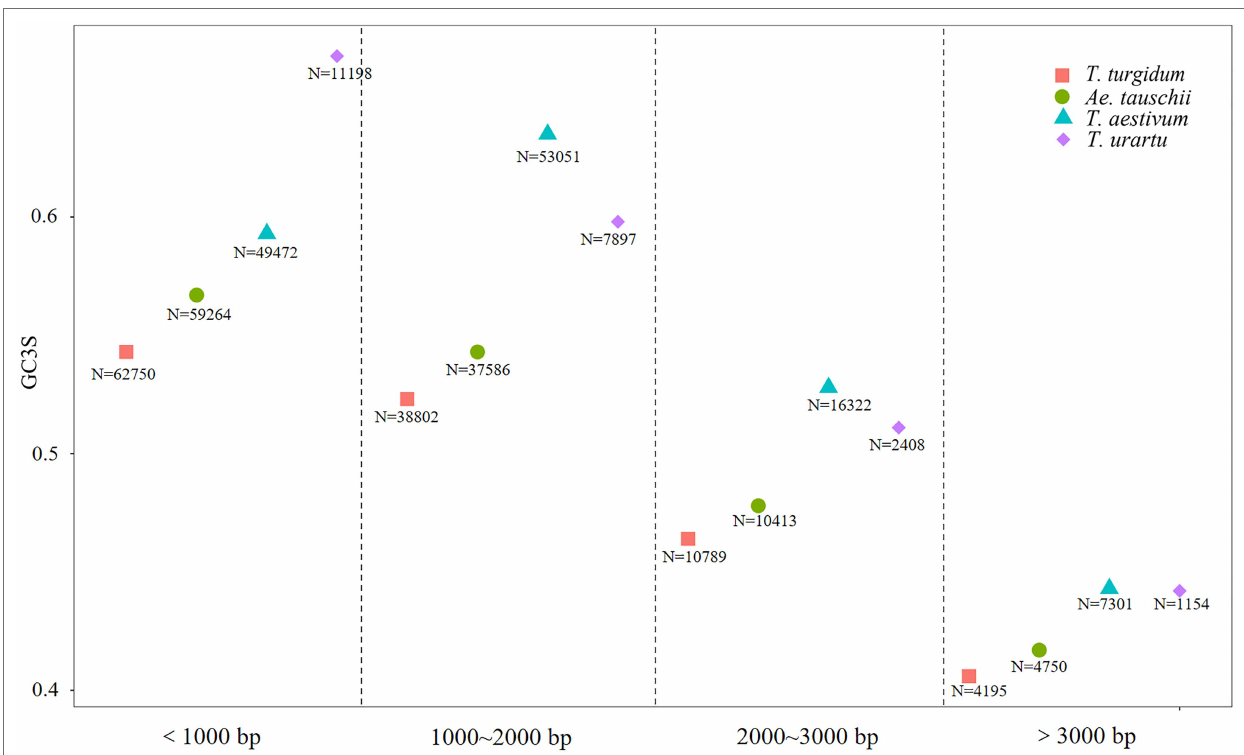
FIGURE 3 | GC3s values in coding sequences from Triticum urartu , Triticum turgidum , Triticum aestivum , and Aegilops tauschii . N is the number of coding sequences